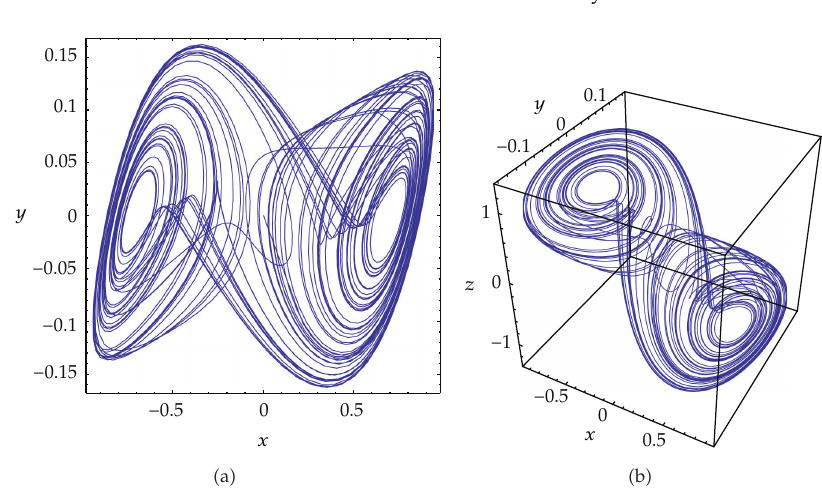
Figure 3: Phase plot of Chua-Hartley’s chaotic attractor with α (cid:7) 9 . 5 and q 1 (cid:7) q 2 (cid:7) q 3 (cid:7) 1: (cid:3) a (cid:4) in the x - y space, (cid:3) b (cid:4) in the x - y - z space.